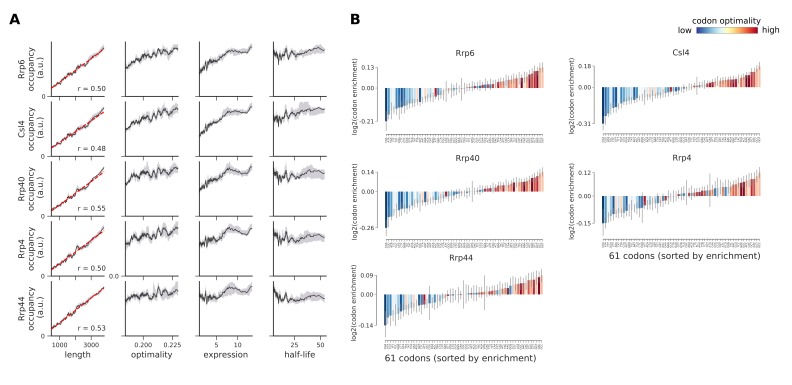
Occupancies of exosome components (Rrp6, Csl4, Rrp40, Rrp4, and Rrp44) compared to transcript length, optimality, expression level, and half-life.(A) To understand binding specificity of exosome components, the total occupancy of each factor on a transcript is plotted against various transcript features (Gray shading: 95% confidence intervals generated by bootstrapping transcripts). (B) Same analysis as in Figure 6B: Codon enrichment shows deviations in codon frequencies of transcripts bound by a degradation factor compared to each codon’s frequency on all coding sequences. Each bar is colored according to its codon-optimality with highly optimal codons in dark red and highly non-optimal codons in dark blue. (Gray lines: 90% confidence intervals generated by bootstrapping coding sequences).